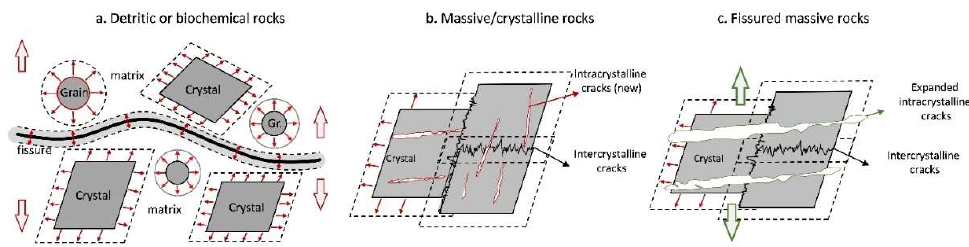
Figure 7. Thermal expansion effects in detritic and massive rocks, enhanced by micro-fissures (modified after [33]). Arrows indicate the direction of particles movement.